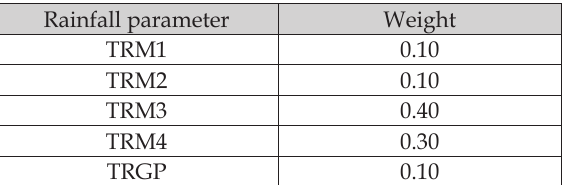
Table 3. Fuzzy suitability interval used for climatic suitability classification.